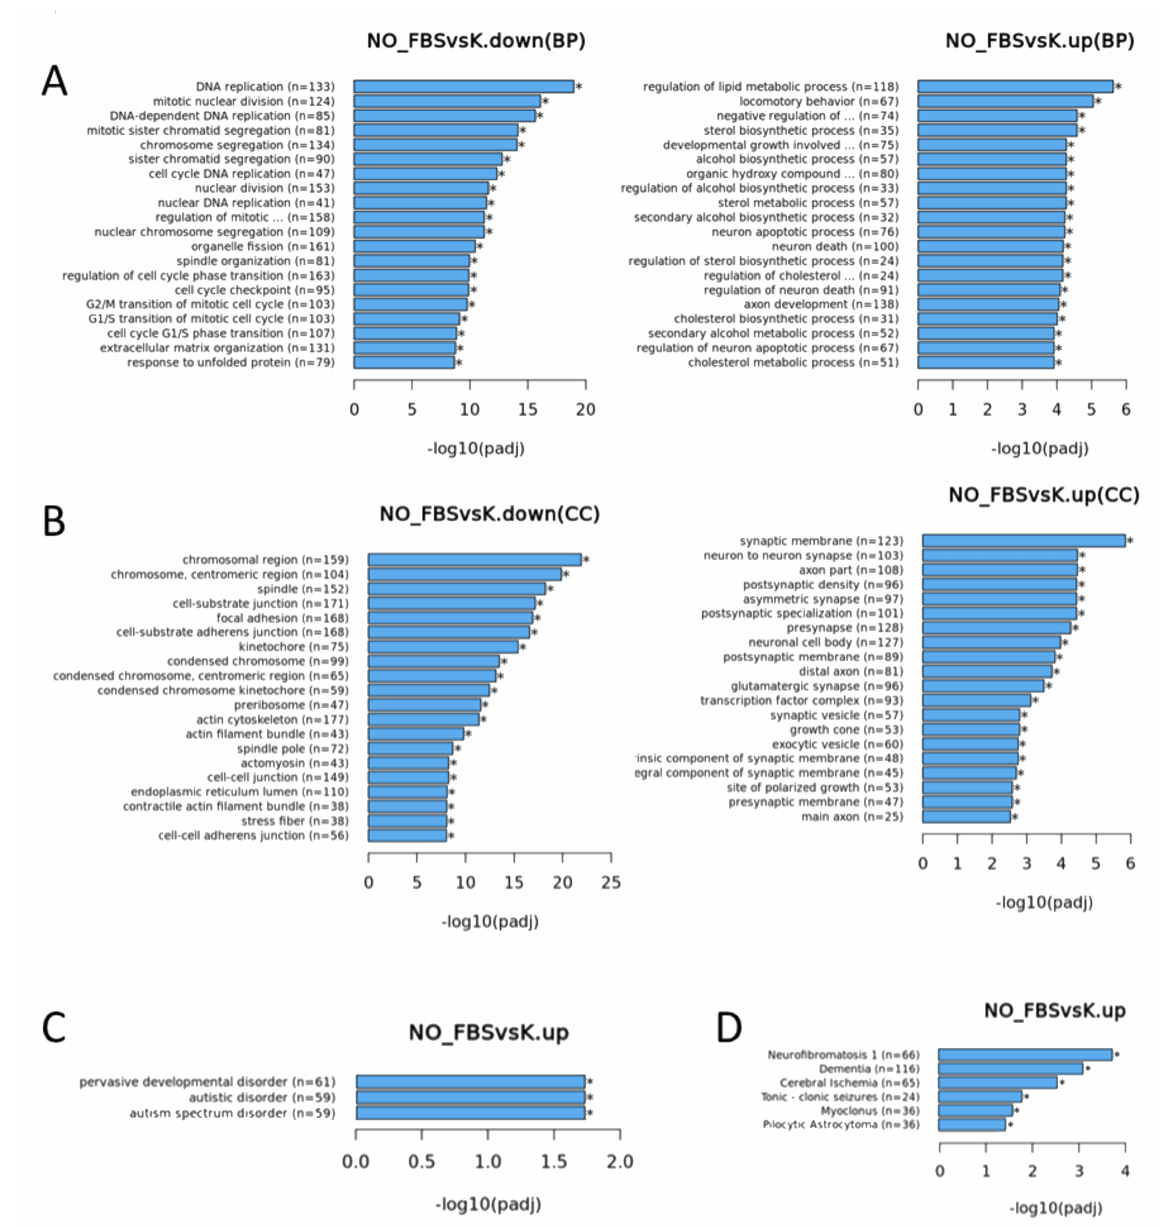
Figure 3. mRNA-seq (cells) GO annotations for differentially expressed genes ( A ) biological processes, ( B ) cellular component, down: downregulated genes, and up: upregulated genes). ( C ) DisGenNET of upregulated genes. ( D ) DO of upregulated genes. NO_FBS: astrocytes in culture for 24 h without 2% FBS, K: astrocyte for 24 h in full medium including 2% FBS. (NO_FBS—serum-free medium and K—medium with 2%